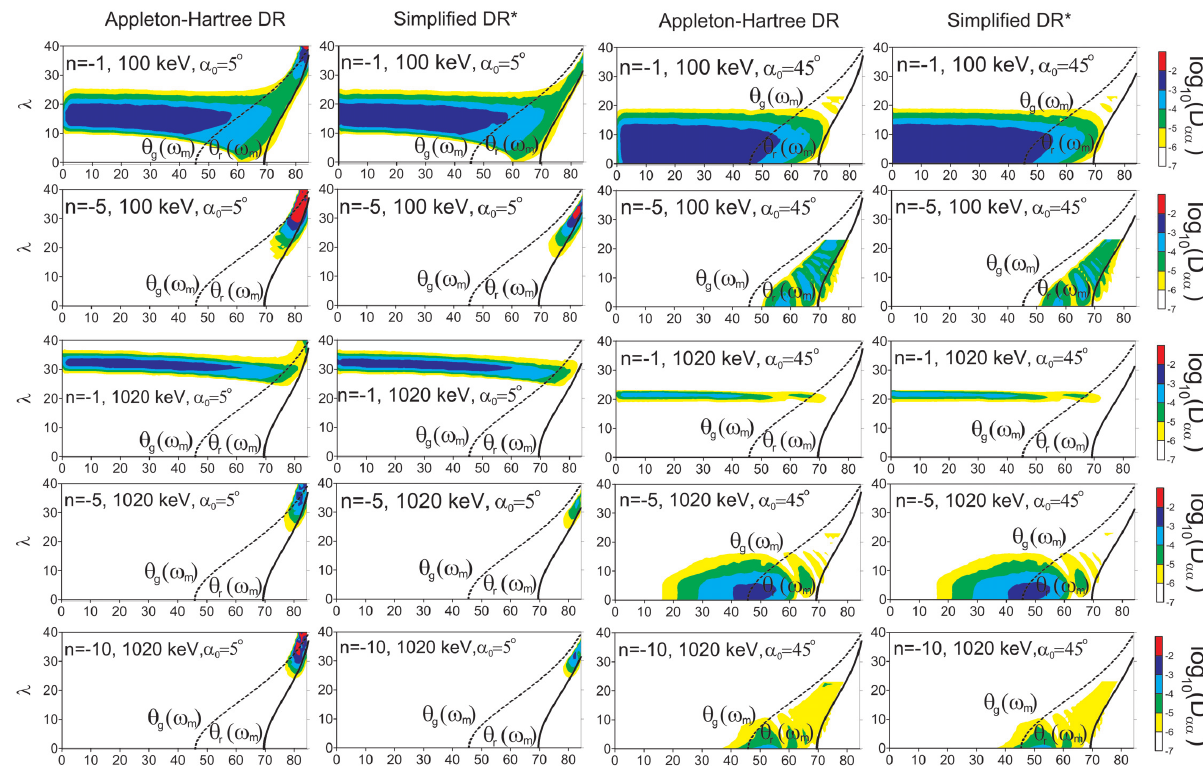
Fig. 10. Local diffusion coefficient D αα for various n , particle energies and equatorial pitch angles (see text for details). The black solid curve shows the position of resonance cone angle θ r . Black dashed curves show the position of the Gendrin angle θ g . Here (cid:127) pe /(cid:127) c0 = 4 . 5.